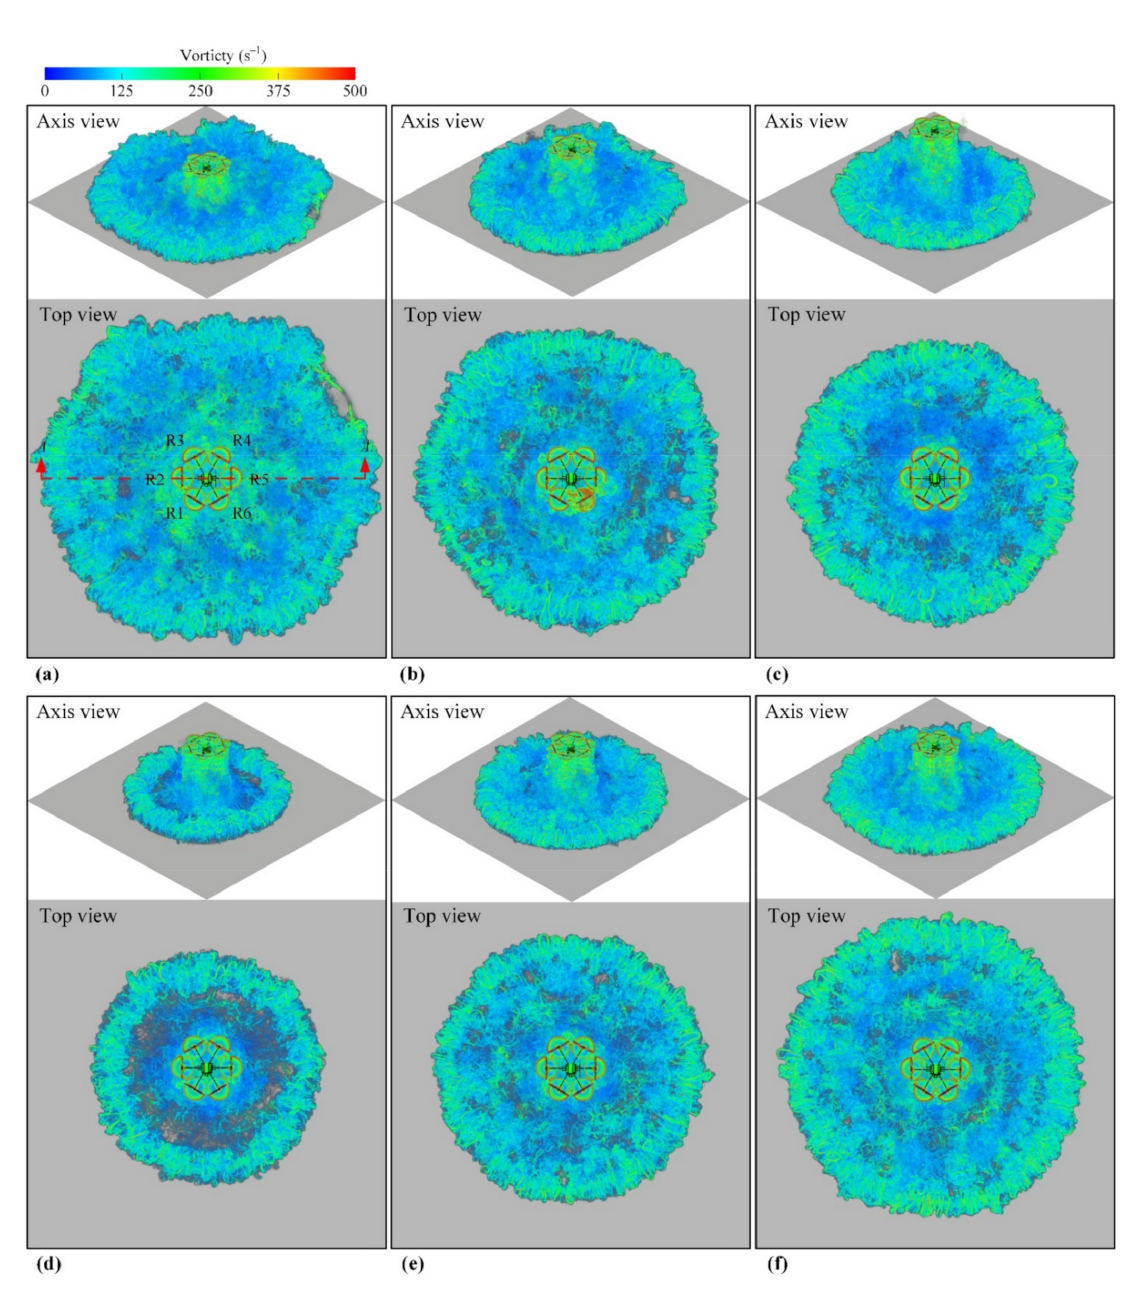
Figure A1. Vorticity distribution diagram of downwash airflow in hovering with axis view and top view ( t = 1.3 s). ( a ) F A = 2 m, L G = 16 kg; ( b ) F A = 3 m, L G = 16 kg; ( c ) F A = 4 m, L G = 16 kg; ( d ) F A = 3 m, L G = 4 kg; ( e ) F A = 3 m, L G = 8 kg; ( f ) F A = 3 m, L G = 12